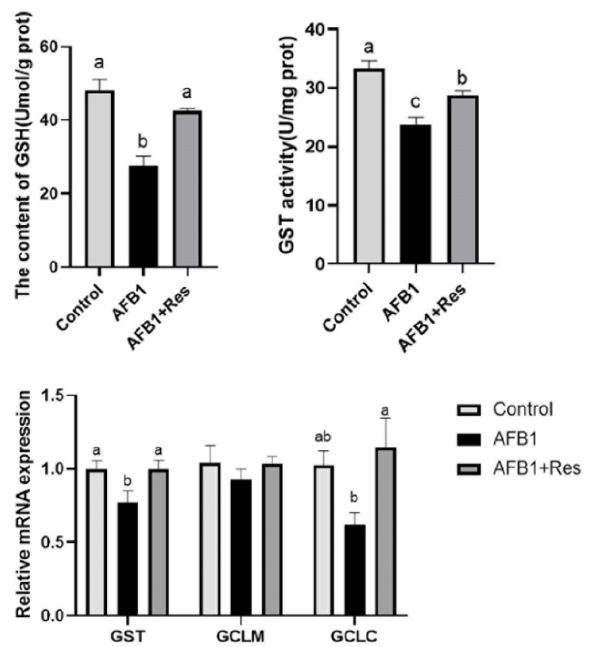
Figure 5. Effect of Res on the GSH content and expression of its regulated genes in the duck liver exposed to AFB1. Values are represented as the mean ± SEM ( n = 6). a–c Mean values with same superscript letters or no letters within a row were of no significant difference ( p > 0.05), those with different superscript letters were of significant or extremely significant difference ( p < 0.05).